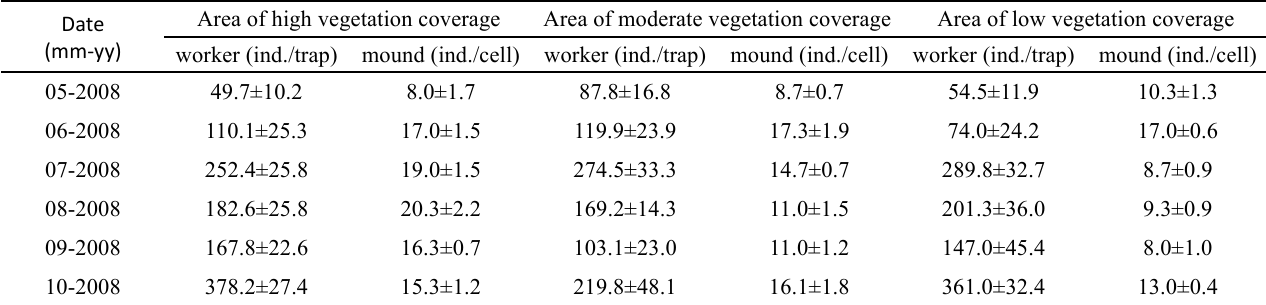
Table 1. Dynamics of S. invicta population in the three types of banana plantations. Area of high vegetation coverage Area of moderate vegetation coverage Area of low vegetation coverage